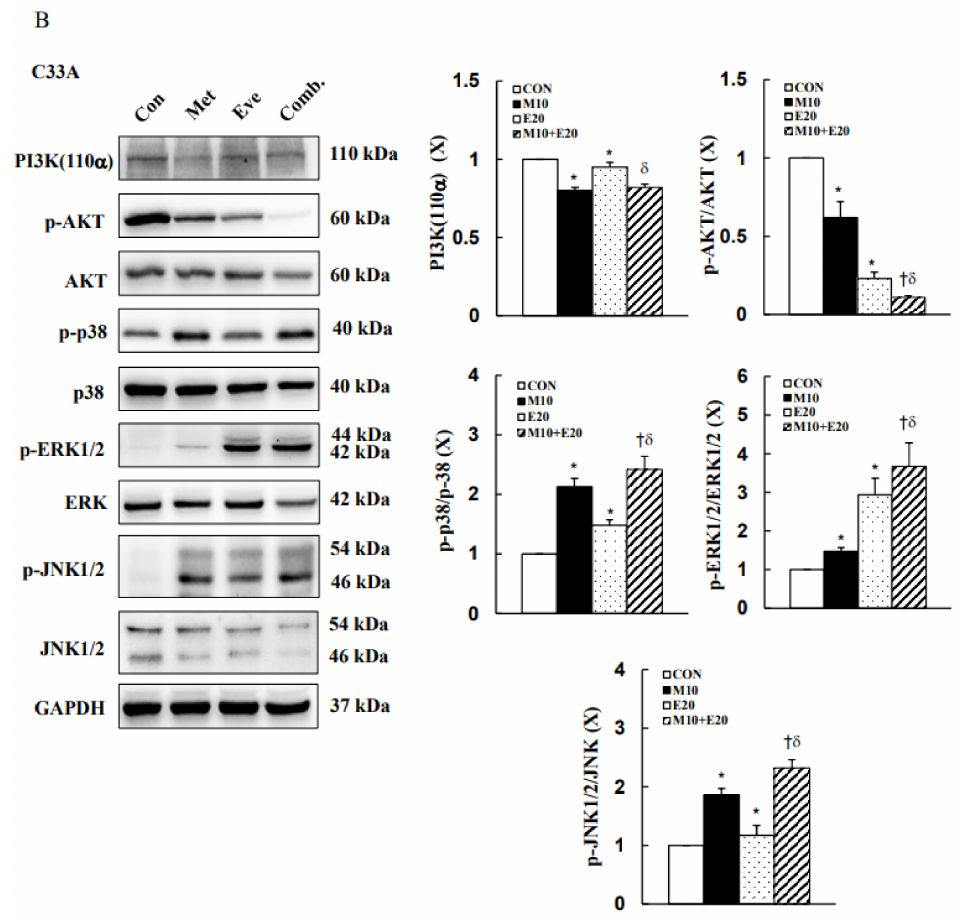
Figure 6. Metformin and everolimus induced apoptosis through the PI3K/AKT and JNK/p38 MAPK signaling pathways in cervical cancer cells. Western blotting was used to detect PIK3CA, p-AKT, AKT, p-p38, p38, p-ERK1/2, ERK1/2, p-JNK1/2, and JNK1/2 levels in ( A ) CaSki and ( B ) C33A cells treated with metformin (10 mM) with or without everolimus (20 µ M) for 48 h. GAPDH served as the loading control. Quantitative results are presented in the bottom plot. Values represent the mean ± SD from three replicates. *, † and δ p < 0.05 compared with CON, Met 10- or Eve 20-treated groups. CON, 0.1% DMSO; M10, 10 mM metformin; E20, 20 µ M